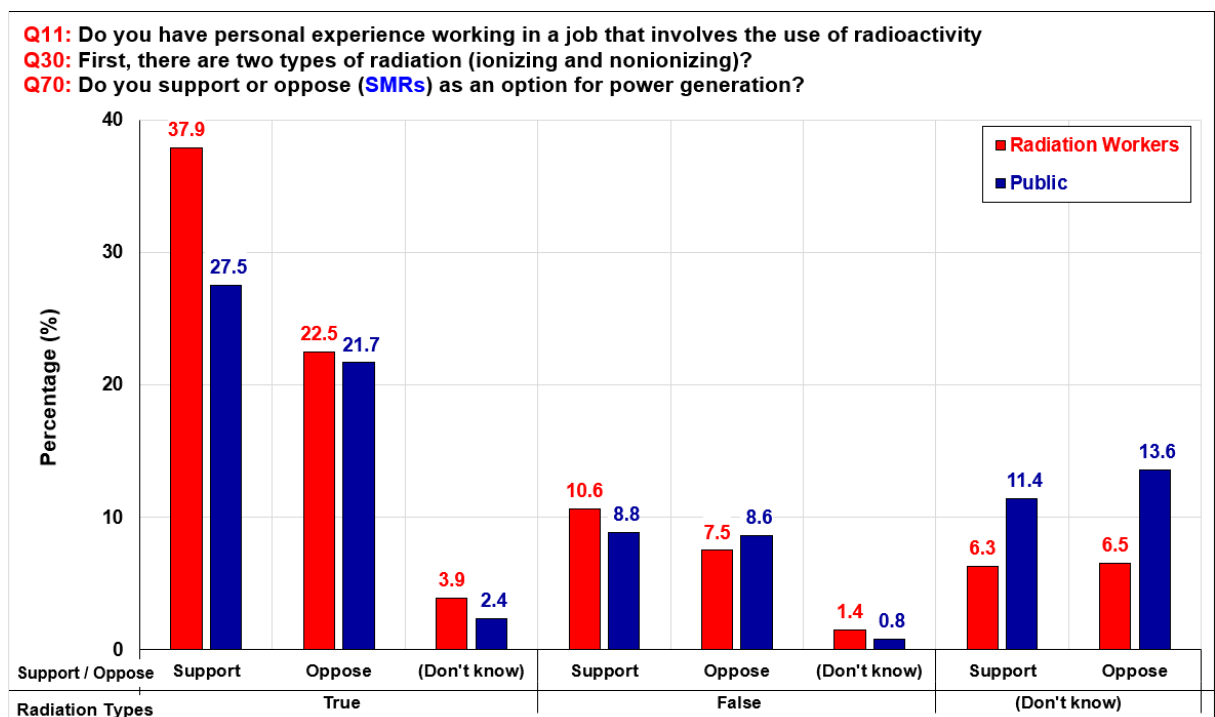
Figure 4. Level of support for SMR power generation by correct answer regarding two types of radiation.